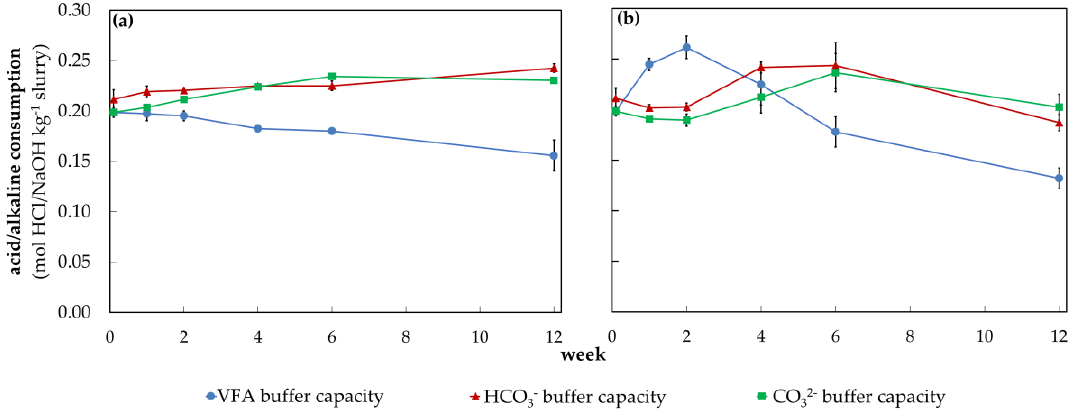
Figure 8. Evolution of the acid/base amount for ( a ) coldly stored (4.7 ± 1.1 °C) and ( b ) warmly stored (23.6 ± 2.1 °C) fattening pig slurry shown over 12 weeks to visualize the dynamics of the VFA (pH range 5.5 to 3.0), HCO 3 − (pH range 7.0 to 5.5) and CO 32 − (pH range 9.5 to 11.5) buffer systems, vertical bars represent standard errors (n = 3).